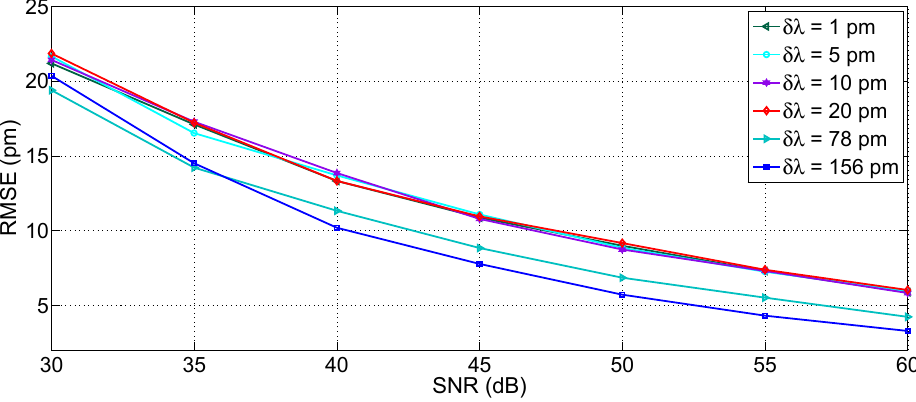
Figure 21. Performance analysis of Gaussian → polynomial peak tracking technique: the RMSE on peak detection is reported as a function of SNR, for different values of sampling grid δλ (1, 5, 10, 20, 78, 156 pm); FBG spectra have been resampled, on a new grid with δλ R = 1 pm.